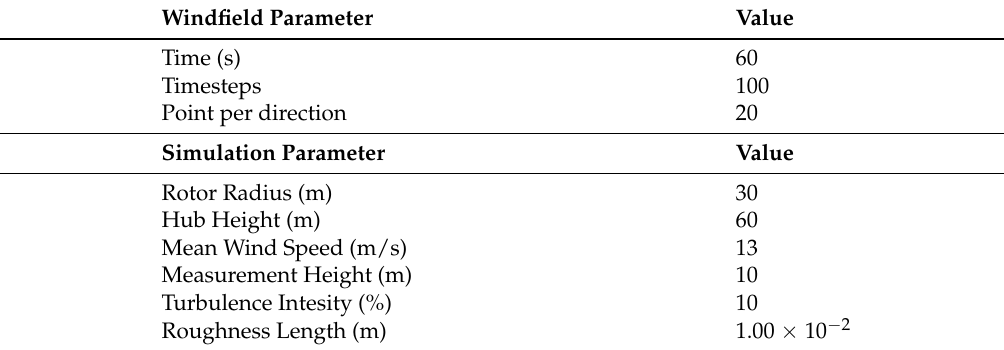
Table 6. Wind field and wind simulation